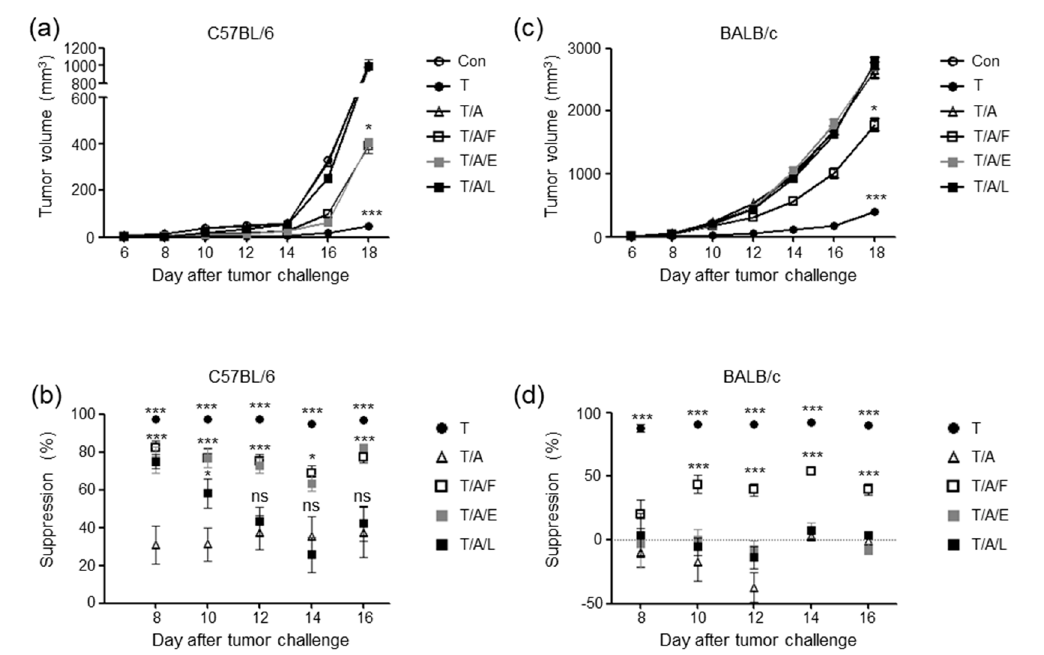
Figure 2. Oral gavage of bacteria restores Tim3VdIg efficacy in antibiotic-treated mice depending on the bacterial species administered and the mouse strain. Tumour growth in B6 ( a ) and BALB/c ( c ) mice injected with B16 melanoma cells and CT-26 cells, respectively. Control group (Con, 8 B6 mice and 4 BALB/c mice) mice were injected with PBS, and the experimental groups were injected with Tim3VdIg once every second day after tumour challenge. Antibiotics were administered via the drinking water. Bacteria were administered to mice through oral gavage seven times in total, once every third day starting seven days before tumour challenge. T: Tim3VdIg treatment alone (9 B6 mice and 10 BALB/c mice). T/A: Tim3VdIg and antibiotic treatment (10 B6 mice and 9 BALB/c mice). T/A/F: Tim3VdIg, antibiotics, and faecal bacteria (10 B6 mice and 9 BALB/c mice). T/A/E: Tim3VdIg, antibiotics, and Enterococcus hirae (7 B6 mice and 6 BALB/c mice). T/A/L: Tim3VdIg, antibiotics, and Lactobacillus johnsonii (7 B6 mice and 6 BALB/c mice). Tumour suppression ( b , d ) was calculated as (1 − tumour volume of each mouse relative to the mean tumour volume of control group mice) × 100. Data represent the mean ± standard deviation of two independent experiments. * p < 0.05, *** p < 0.001 vs Con or T/A.